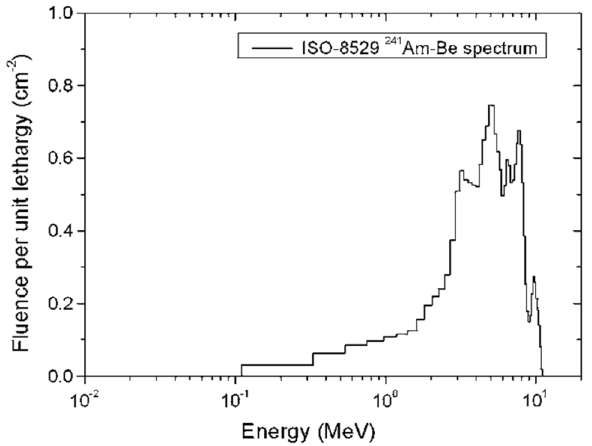
Figure 1. 241 Am/Be neutron spectrum from ISO 8529 used for Monte Carlo Simulation. The PHITS input code uses this spectrum for the neutron emission from DSRSs under investigation.